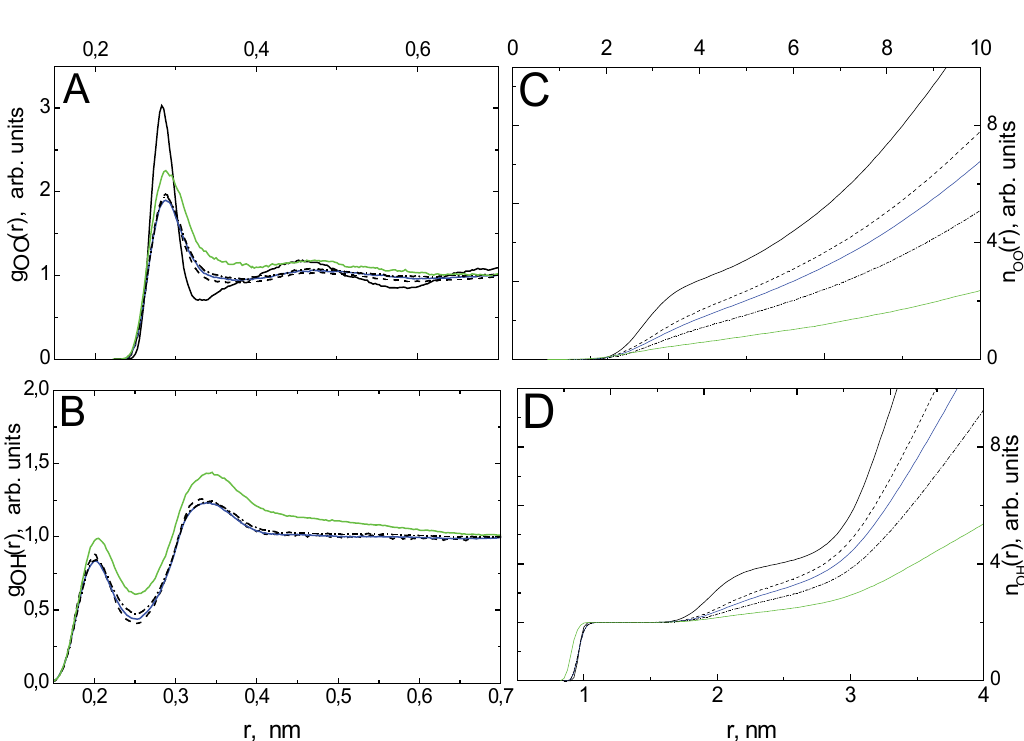
Figure 2. Oxygen-oxygen (A) and oxygen-hydrogen (B) radial pair distribution functions and the respective cumulative RDFs (C, D) calculated for water at temperatures and densities corresponding to the thermodynamic points TS1 (––––) , TS2 (– – –) , TS3 (–––– ) , TS4 (─ ∙ ─) , TS5 (–––– ) . Table 2. The calculated average properties of water molecules in the thermodynamic states studied: the bond length l moment µ *) and the number of hydrogen-bonded neighbours <n the last